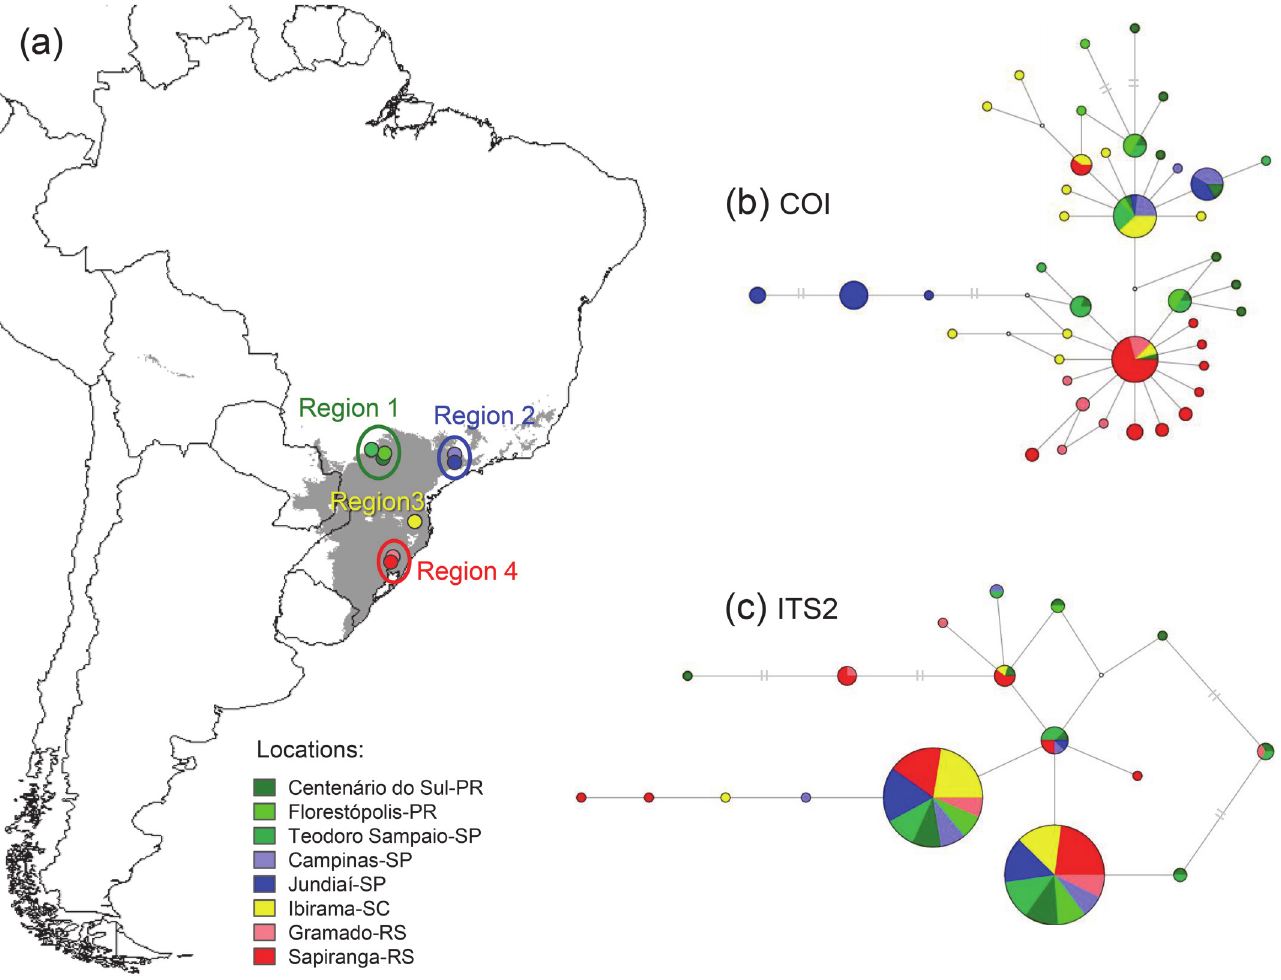
Fig 1. Study region and median-joining haplotype networks. (a) Sampling locations of Araneus omnicolor (separated by geographical regions). The current species distribution area calculated by climate models is shown in gray. (b) Mitochondrial and (c) nuclear networks. Circle sizes represent haplotype frequencies; colors correspond to sample locations on the